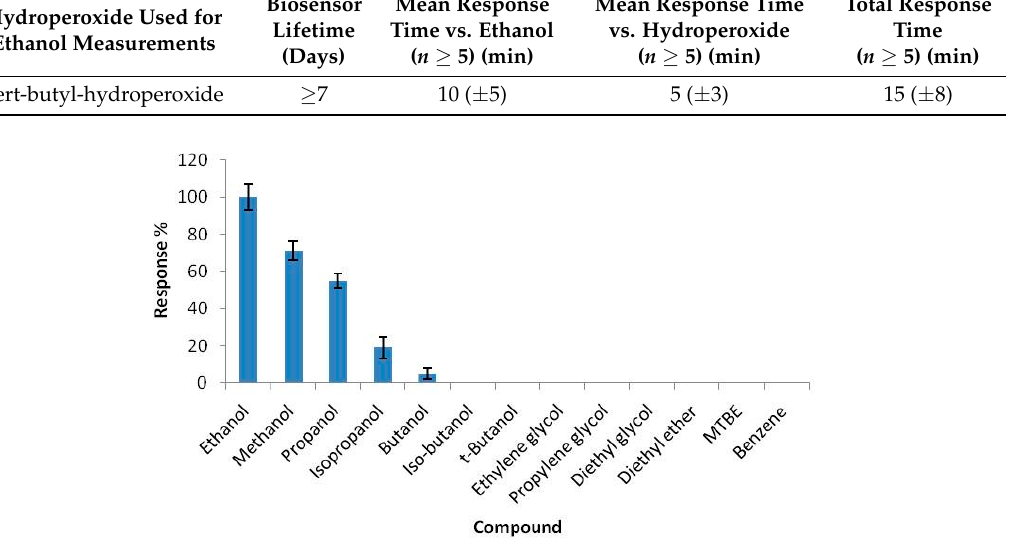
Table 2. Biosensor response time and lifetime using t-BuOOH, operating in decane. Hydroperoxide Used for Ethanol Measurements